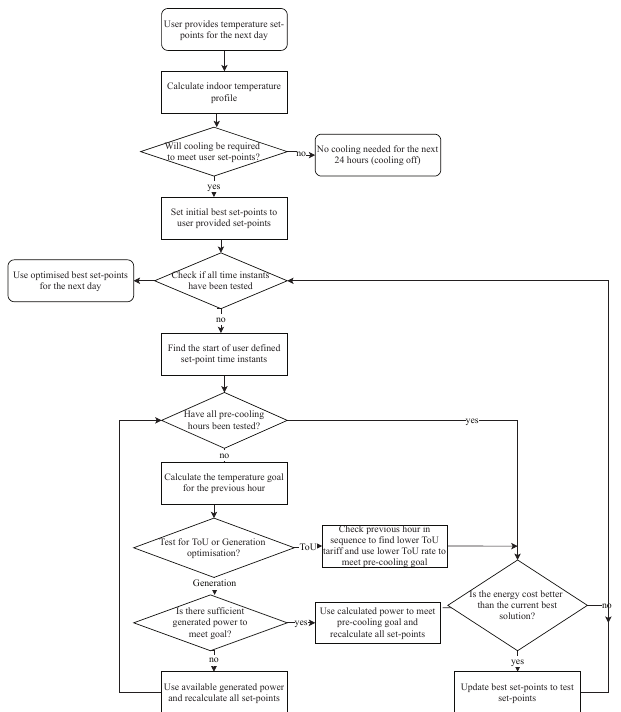
Figure 1. Solution approach for optimum scheduling of the AC